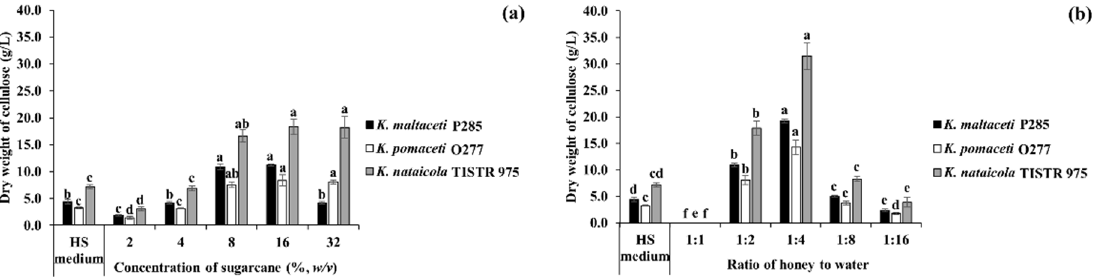
Figure 4. The influence of sugarcane ( a ); and honey ( b ) on bacterial cellulose production by K. maltaceti P285 and K. pomaceti O277. The K. nataicola TISTR 975 was used as control. Data expressed mean ± standard deviation ( n = 3). The difference letters were considered statistically significant ( p < 0.05) for each bacterial strain.